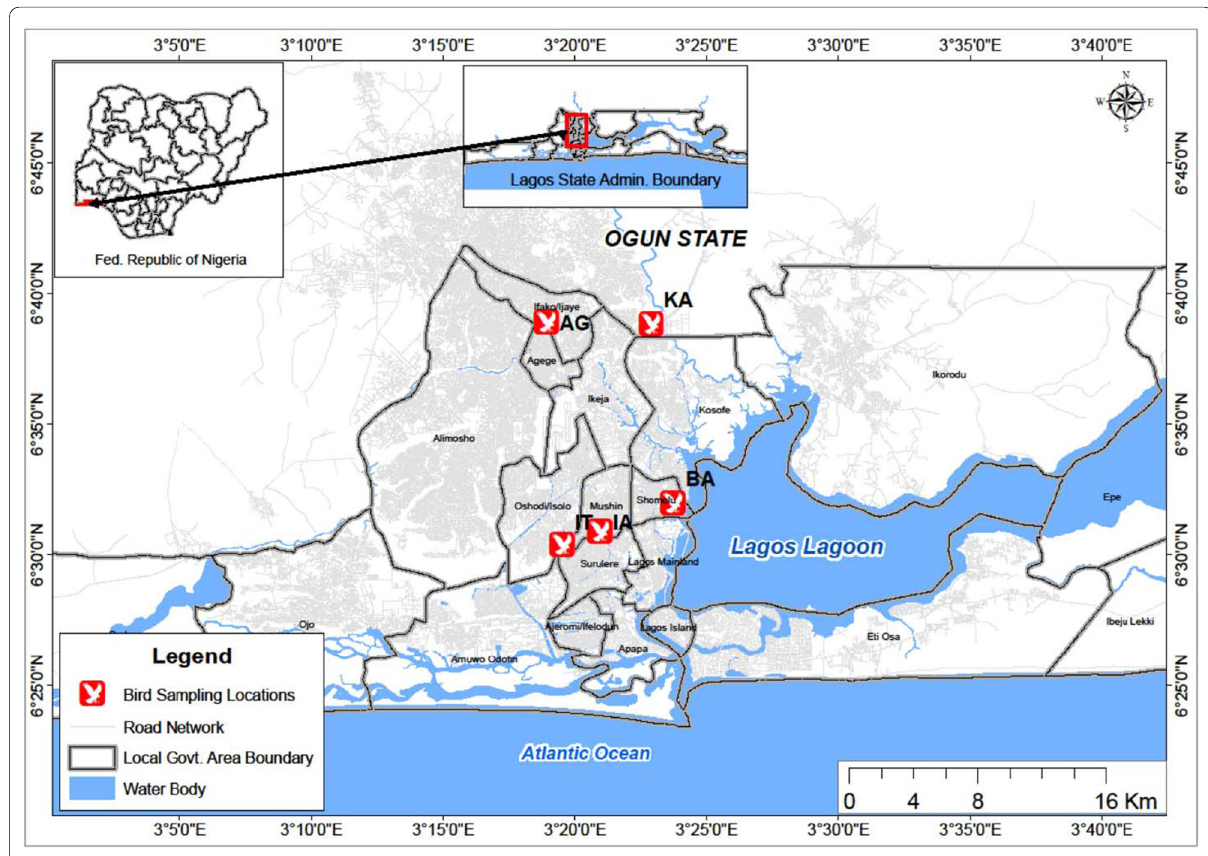
Fig. 1 A map showing the location of the abattoirs in Lagos